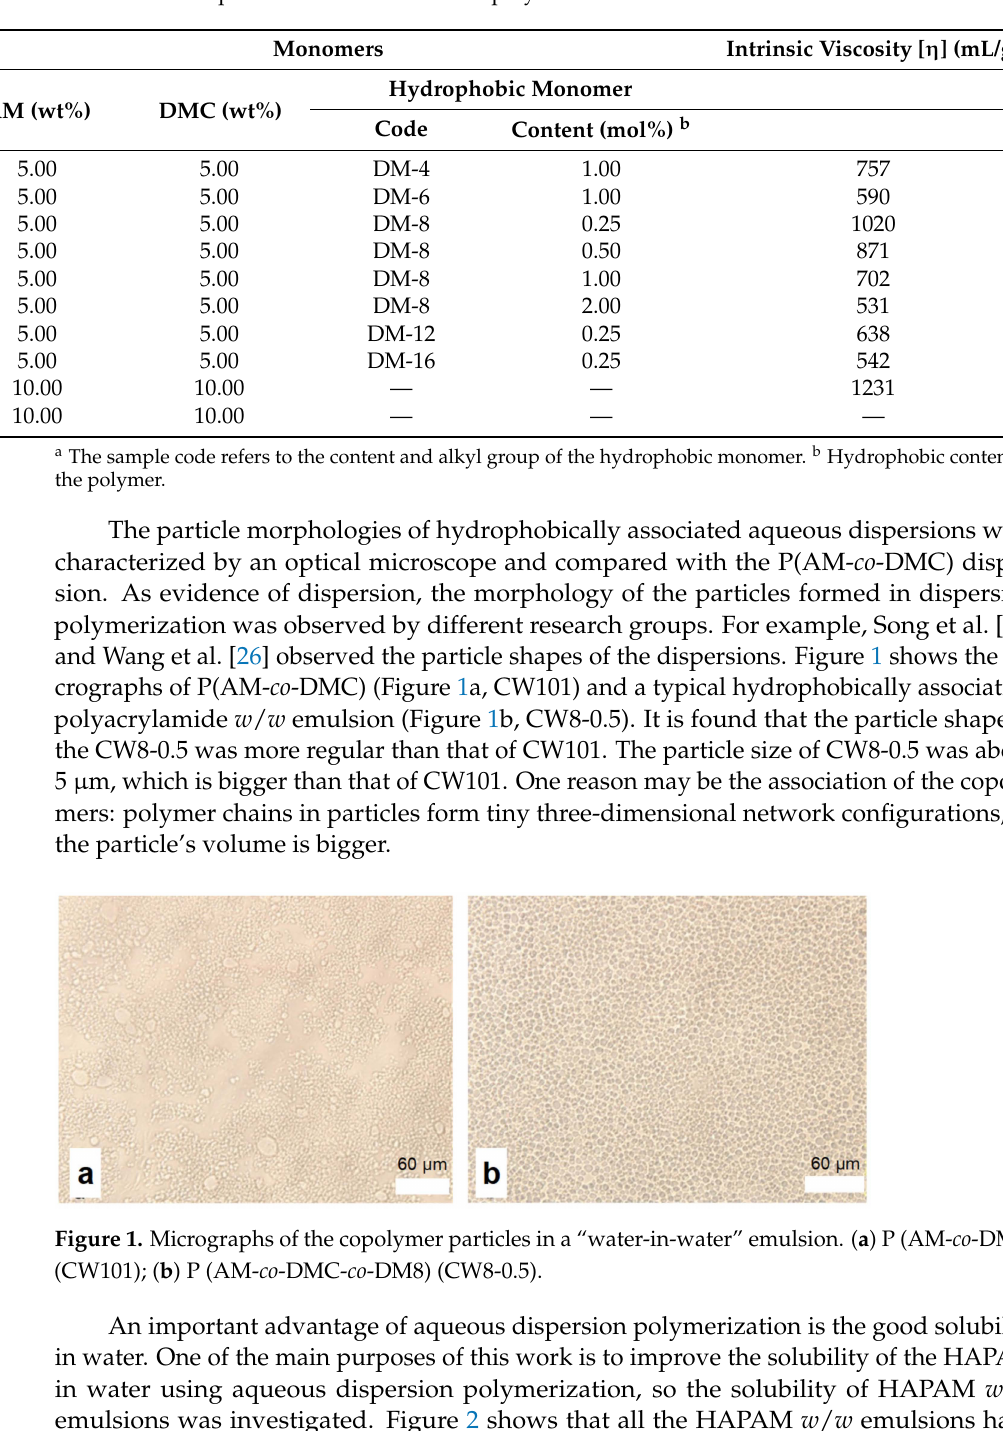
Table 1. The recipes and characters of the copolymers.